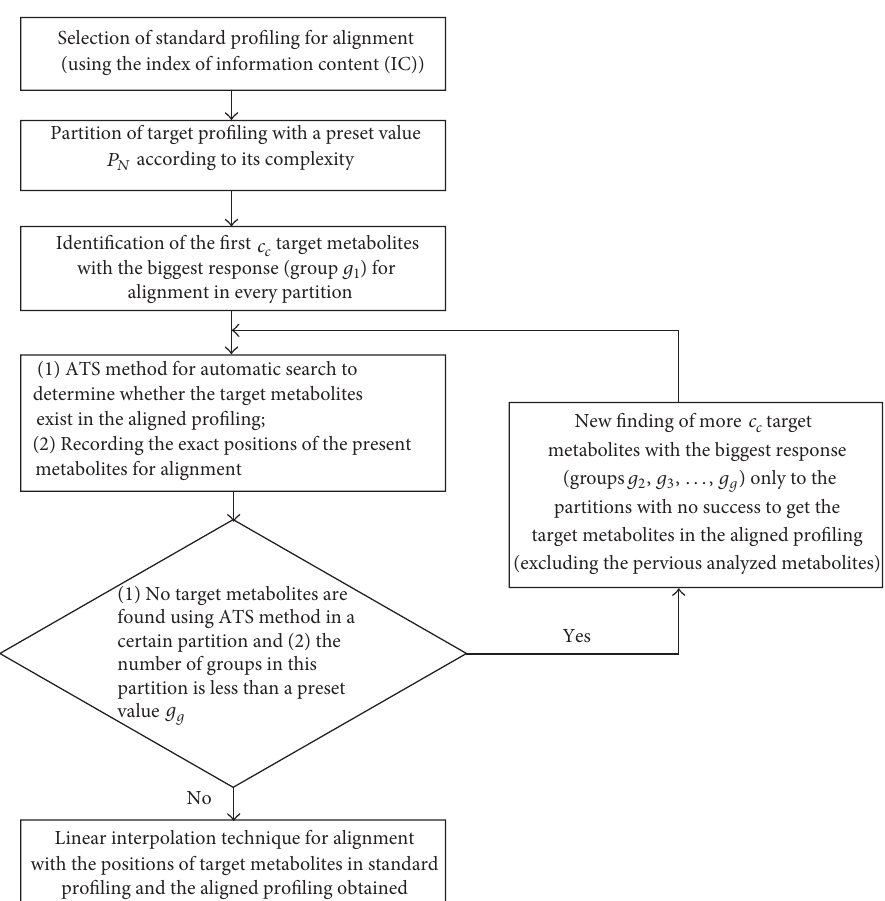
Figure 2: The entire working procedure for the developed method in this